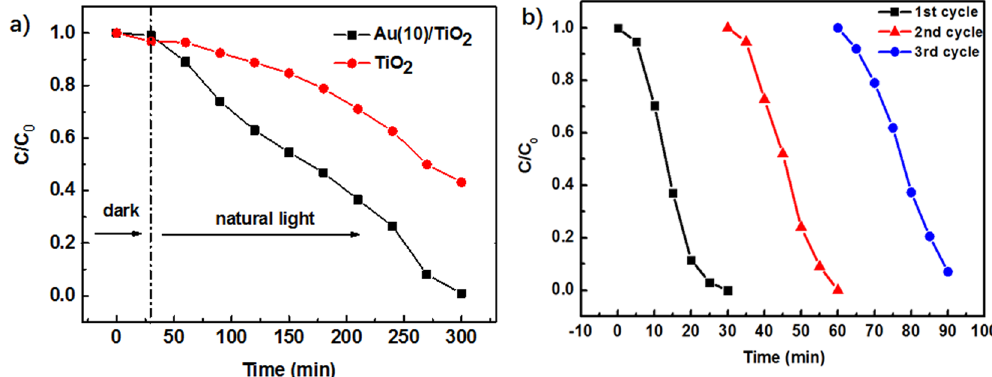
Figure 5. ( a ) Photodegradation rate of RB solution for pure TiO 2 nanofibers and Au(10)/TiO 2 nanofibers under nature light irradiation (15mw/cm 2 ); ( b ) Photocatalytic activity of the Au(10)/TiO 2 nanofibers for RB solution degradation with three times of cycling uses.